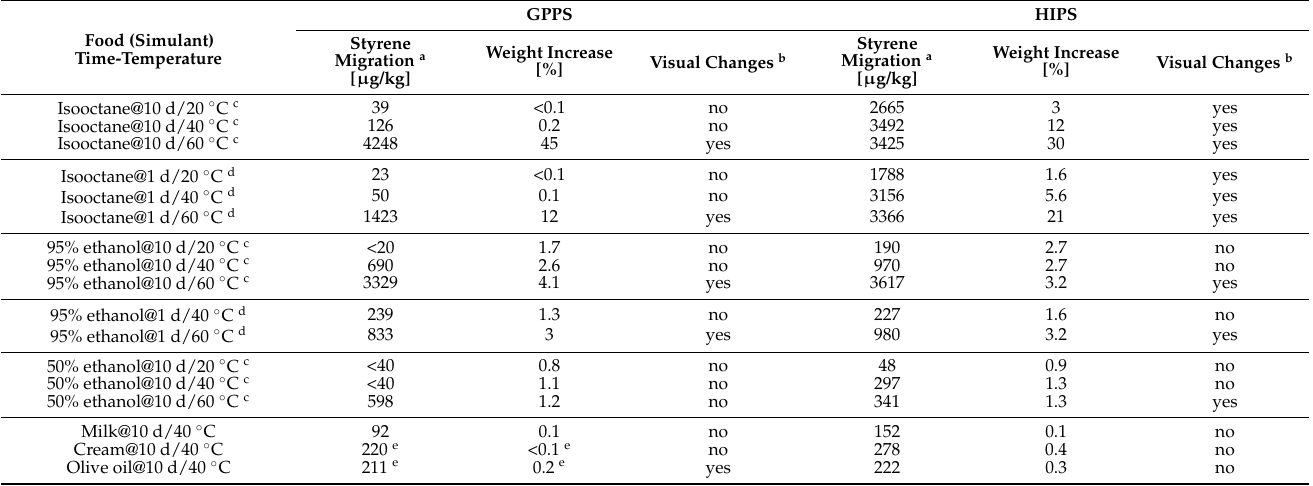
Table 6. Migration of styrene in food simulants and real foods at different time/temperature testing conditions, weight increase and visual changes of the sample material.